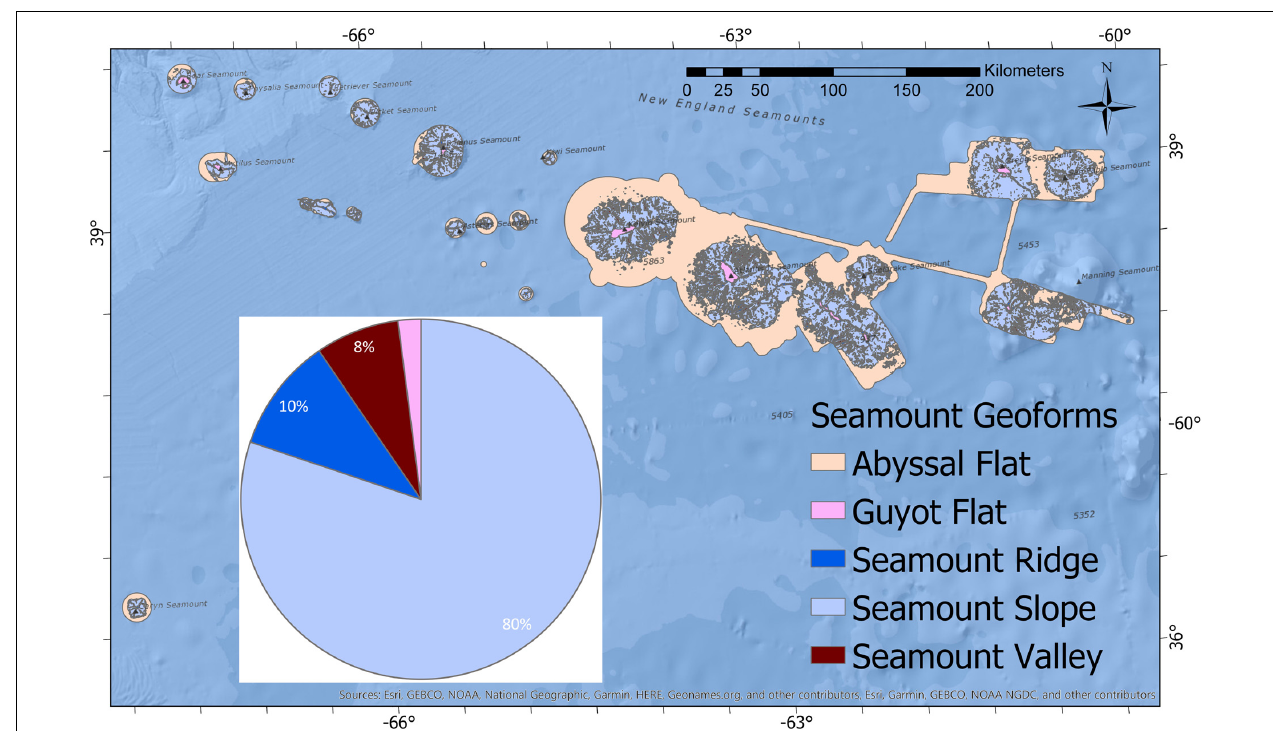
FIGURE 5 | CMECS geoform classifications specific to seamounts. The tan area shown in the figure met the definition of the “abyssal flat” class and was added to that class for calculating overall study region summary statistics and for the map shown in Figure 11 of all geoform classes for the whole region.